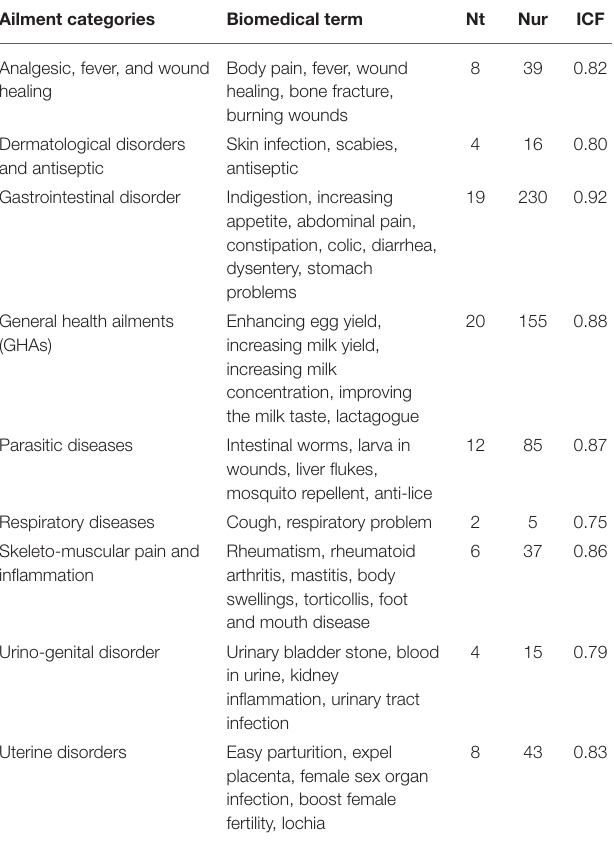
TABLE 4 | Ailment categories and informant consensus factors or ICFs. Ailment